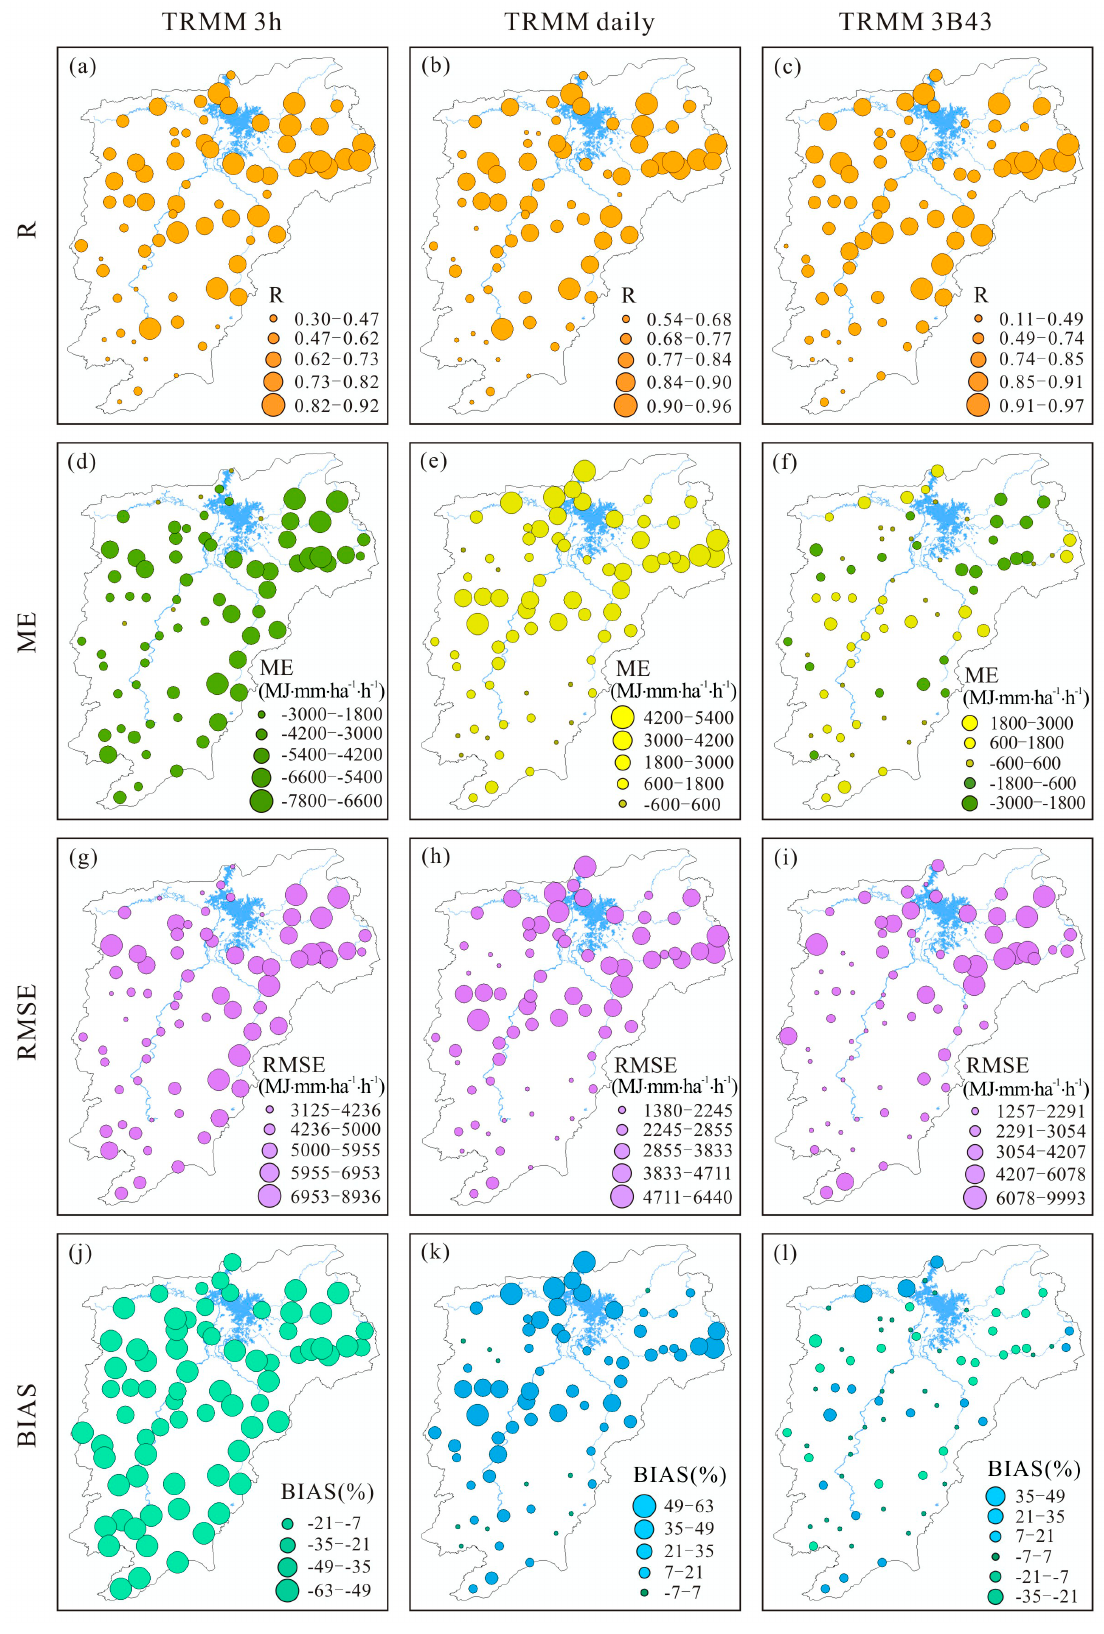
Figure 11. Spatial distributions of R ( a , b , c ), ME ( d , e , f ), RMSE ( g , h , i ) and BIAS ( j , k , l ) of annual RE estimation from TRMM 3h ( a , d , g , j ), daily ( b , e , h , k ) and 3B43 ( c , f , i , l ) products.